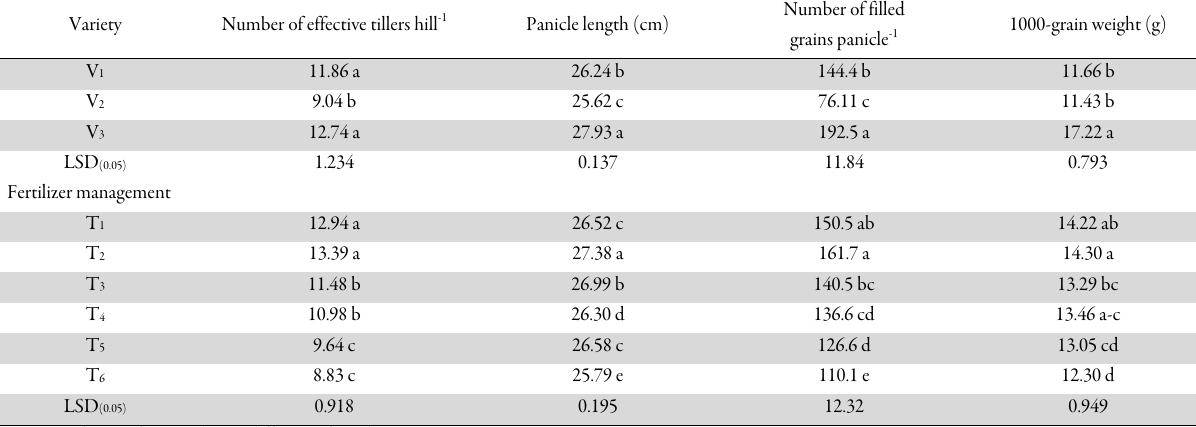
Table 3. Effect of varietal variation and fertilizer management on yield contributing characters of rice Variety